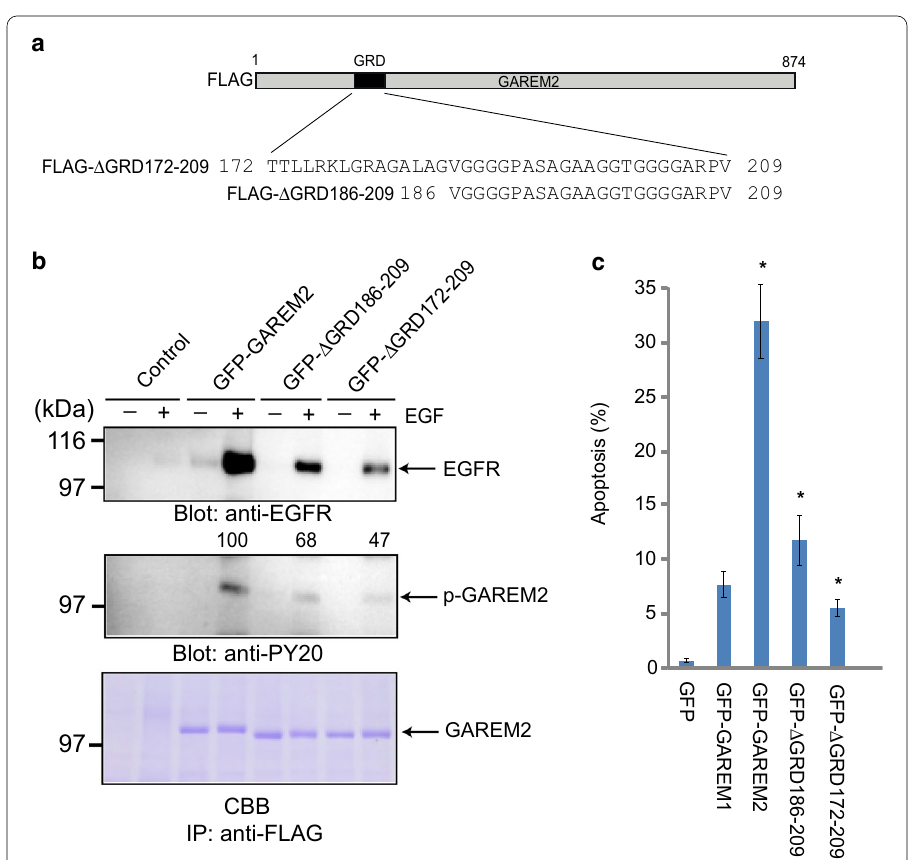
Fig. 4 Effects of glycine-rich domain (GRD) in GAREM2 on the levels of tyrosine phosphorylation and bound to EGFR of GAREM2 dependent on EGF stimulation. a Schematics of the primary structure of FLAG-tagged full length GAREM2 (upper panel) and its deletion constructs lacking GRD (∆GRD186-209 and ∆GRD172-209). b Reduction of the tyrosine phosphorylation level of GAREM2 lacking GRD. All recombinant proteins were expressed as the N-terminal FLAG-tagged form. Each construct was transfected into COS-7 cells, and immunoprecipitation studies were carried out using the cell lysates from COS-7 cells. Each FLAG-tagged molecule was immunoprecipitated with an anti-FLAG antibody. FLAG-GAREM2 derivatives were visualized by CBB staining (bottom panel). Immunoblot analysis was carried out using an anti-pY20 antibody (middle panel) or an anti-EGFR antibody (upper panel). The levels of the tyrosine phosphorylation of FLAG-GAREM2 derivatives were quantified by densitometry. The representative results from three independent experiments are indicated below each panel. The amounts of FLAG-GAREM2 mutants are normalized to the control (wild type FLAG-GAREM2). c Graph showing the percentage of apoptosis induced by expressing each GFP-fused protein as